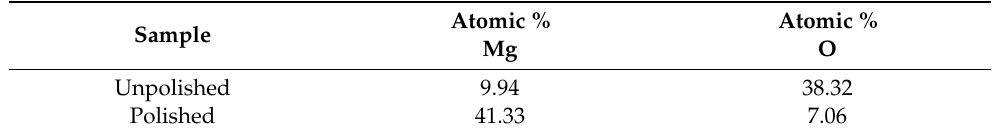
Figure 1. SEM and EDX analysis of Mg filaments as received (Unpolished) ( a – d ) and after acid treatment and polishing (Polished) ( e – h ). SEM images are shown in ( a , e ), merged EDX images in ( b , f ), oxygen in ( c , g ), and Mg in ( d , h ). With copyright permission from [35]. Table 1. Effects of polishing on the atomic percentages of oxygen (O) and magnesium (Mg) on the surface, determined by EDX. With copyright permission from [35].